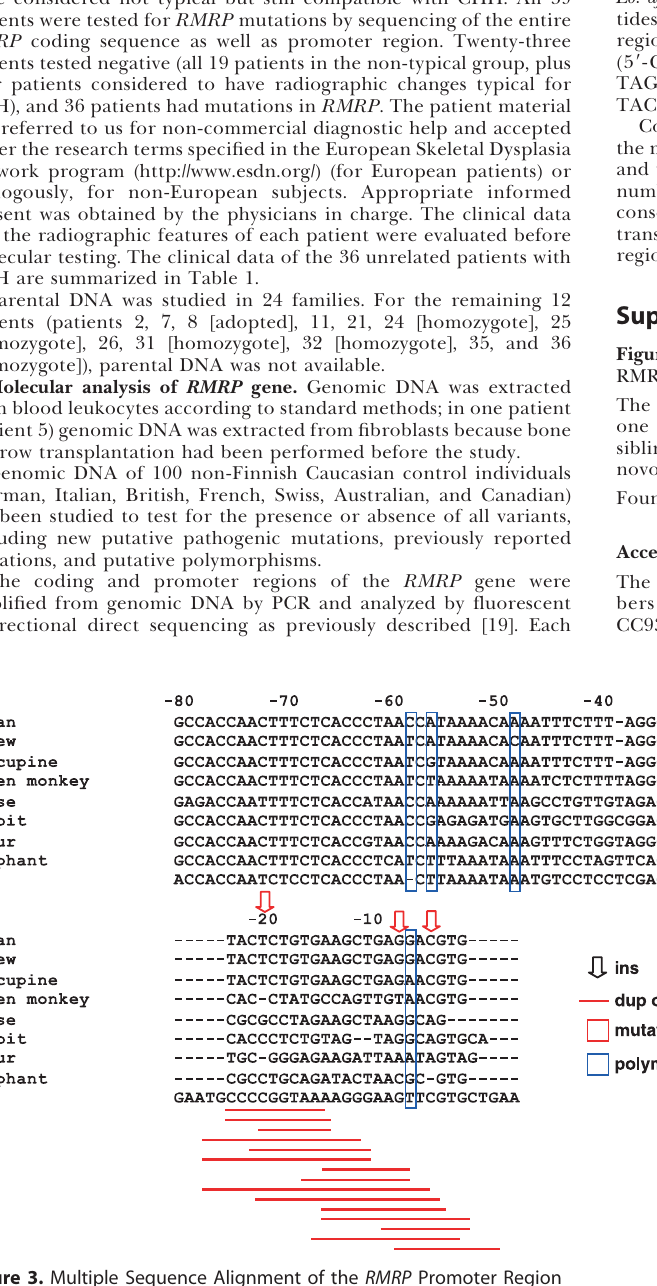
Figure 3. Multiple Sequence Alignment of the RMRP Promoter Region The sequence alignment of the RMRP promoter region of nine mammalian species (from nucleotide g. (cid:2) 80 to the transcription initiation site of the human sequence) is shown. Polymorphisms and rare variants are indicated as blue boxes (single nucleotide changes); red arrows indicate pathogenic insertions, and red lines indicate pathogenic duplications and triplications. Conservation of nucleotides was analyzed for the single nucleotide substitutions (putative polymorphisms) included in the alignment interval (from g. (cid:2) 80 to g. (cid:2) 1). Positions were considered as conserved if eight out of nine species had the same nucleotide. DOI: